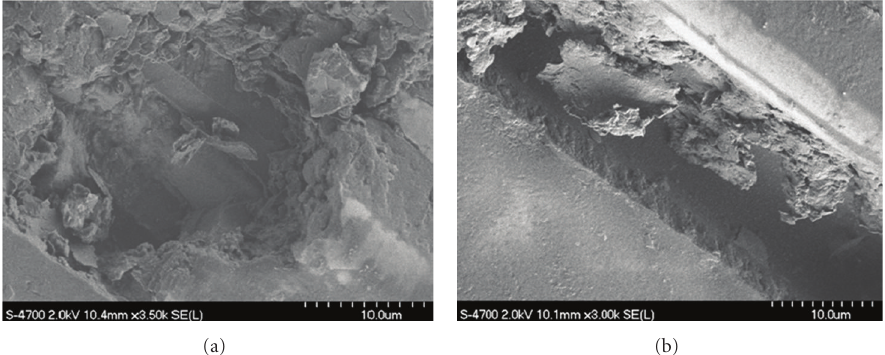
Figure 9: SEM image showing typical (a) voids and (b) cracks in the matrix of the perforated GFRP specimen aged in humidity at 80 ◦